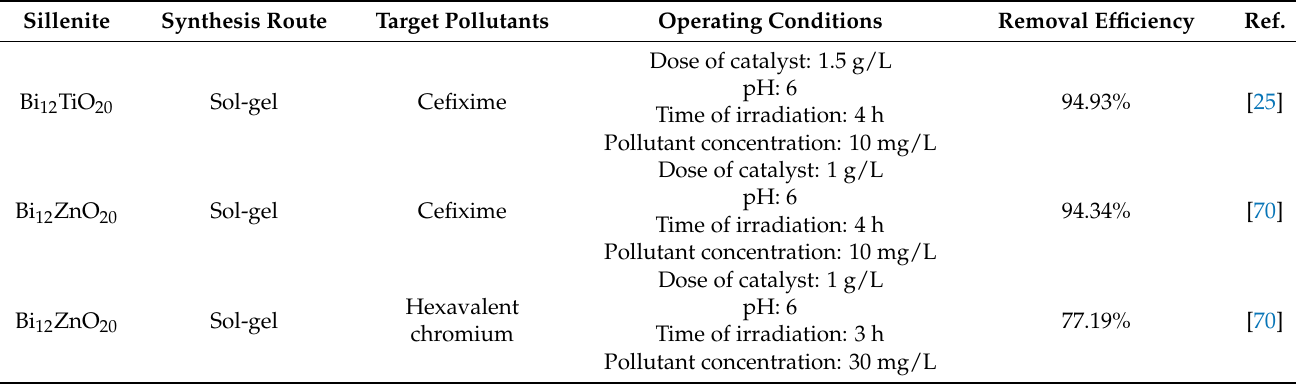
Table 1. Sillenite photocatalysts for environmental